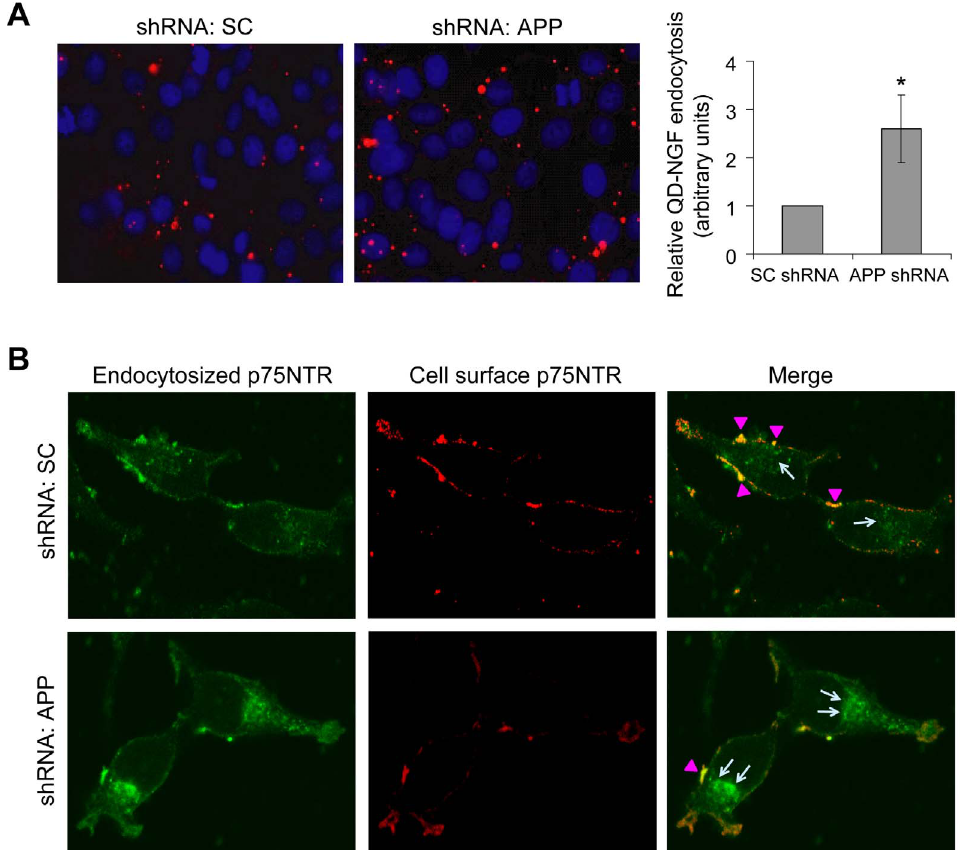
Figure 2. APP deficiency promotes endocytosis of NGF and NGF receptors. (A) PC12 cells stably expressing APP shRNA and control cells expressing scrambled control (SC) shRNA were treated with 1 nM QD-NGF for 3 h. After a complete wash, cells were fixed, permeabilized, stained with DAPI, and observed under a fluorescent microscope. Residual QD-NGF (in red) levels were quantified from 5 randomly selected regions with comparable cell numbers. Control was set as one arbitrary unit. *: P , 0.05. (B) Cells were first incubated with a p75NTR antibody at 4 u C for 1 h, and then treated with 100 ng/mL NGF at 37 u C for 1 h. Cells were fixed and incubated with a secondary antibody conjugated with Alexa Fluor H -594 for 1 h. After a complete wash, cells were permeabilized and then incubated with another secondary antibody conjugated with Alexa Fluor-488. Cells were observed under a confocal microscrope. Arrows and arrow heads indicate internalized and cell surface p75NTR, respectively.